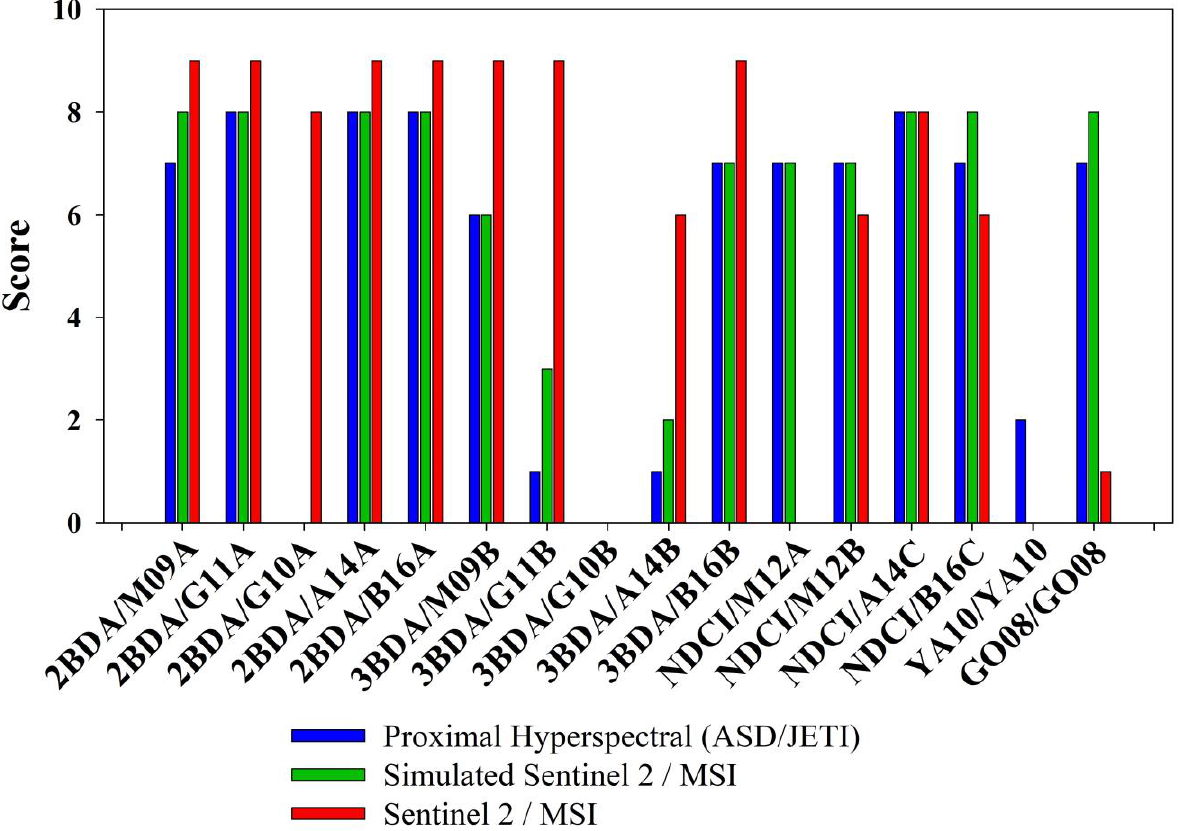
Figure 5. Calculated scores for different chl- a bio-optical algorithms and calibrations using proximal hyperspectral data for 19 lakes ( n = 97), simulated Sentinel-2/MSI for 19 lakes ( n = 97) and the Sentinel-2/MSI image for Havel Lakes ( n = 32).